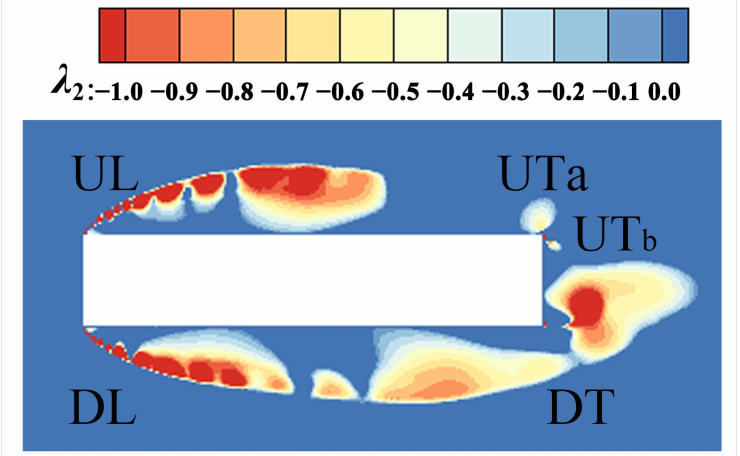
Figure 17. Schematic diagram of vortex naming.